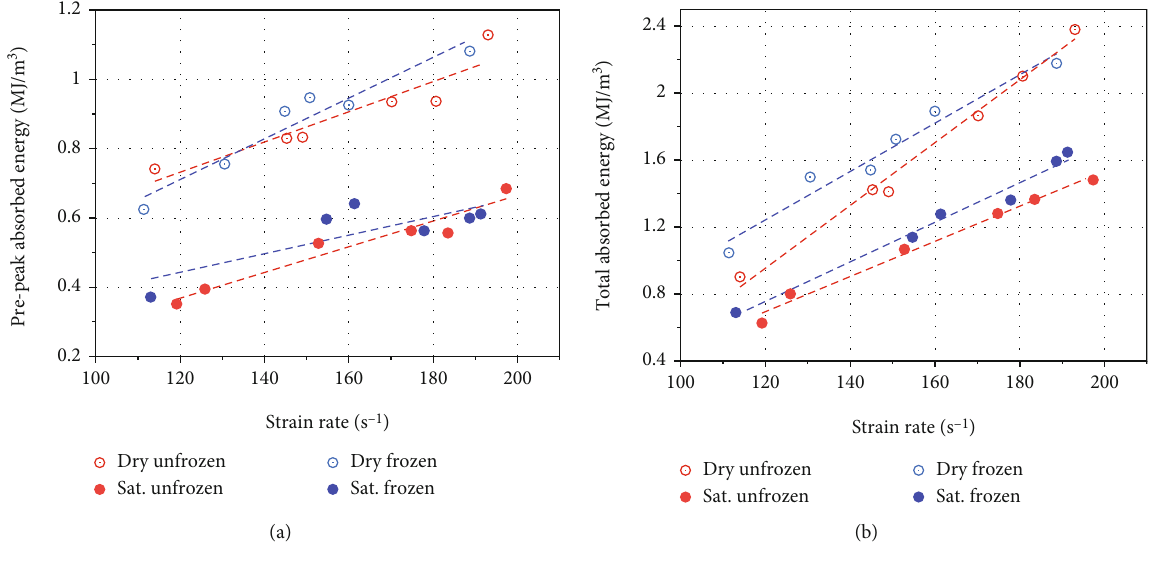
Figure 12: Variations of (a) e